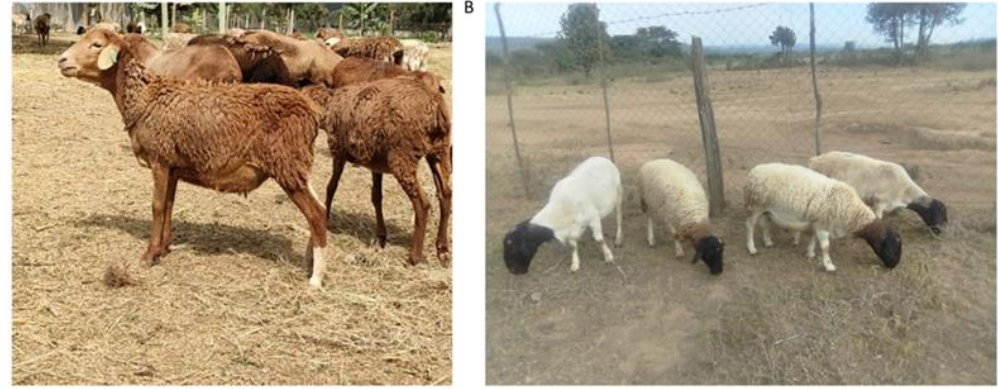
Figure 1. RedM ( A )and Dorper ( B ) sheep.